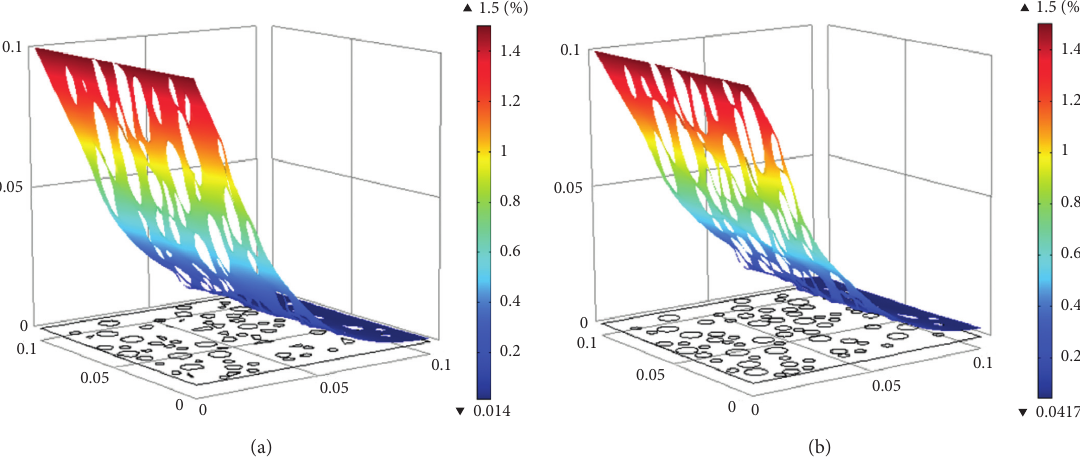
Figure 9: Distribution profile of chloride concentration from the mesoscopic model. (a) Polygonal aggregate. (b) Circular